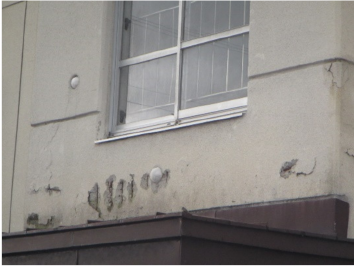
Figure 5. An example of the window surroundings where the survey was